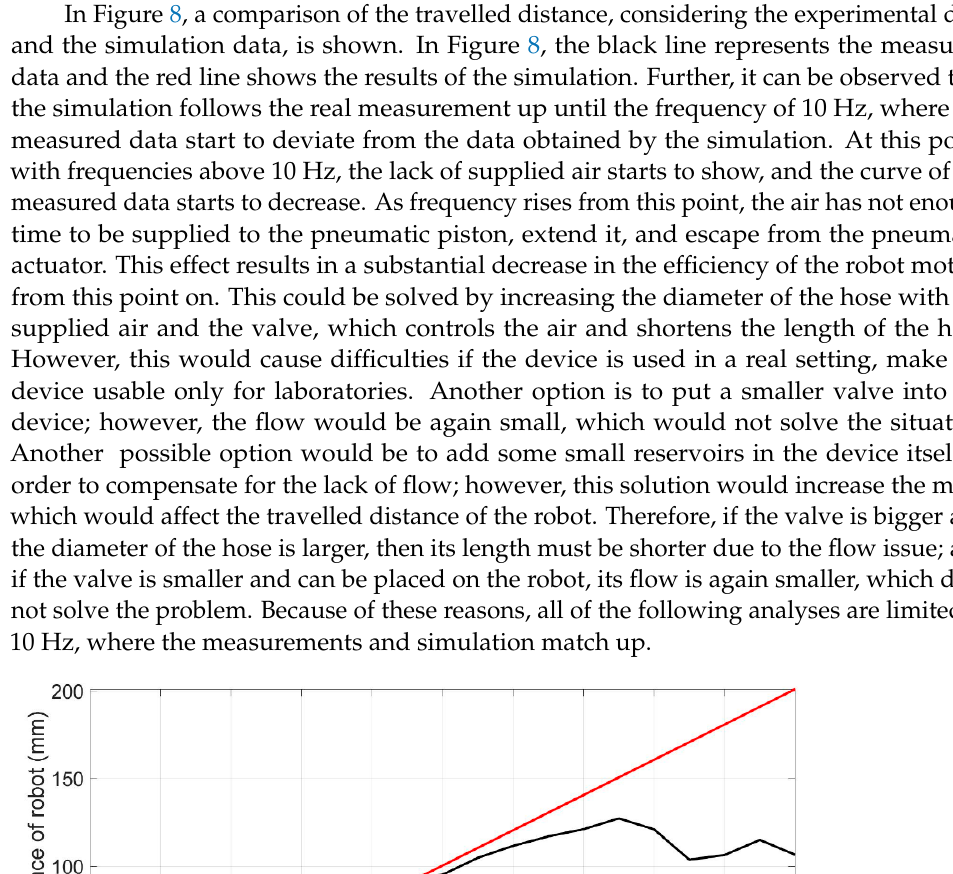
Figure 8. Comparison of experimental and simulation data .